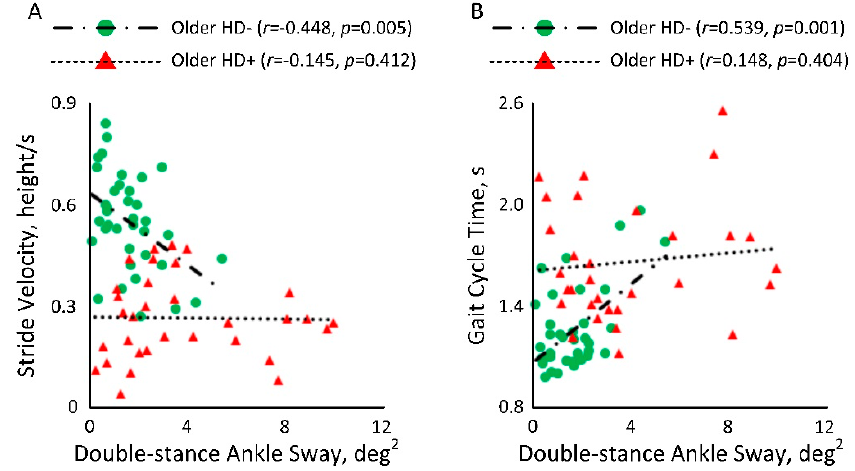
Figure 4. Correlation between double-stance ankle sway and ( A ) normalized stride velocity and ( B ) gait cycle time among older adults with diabetes with and without HD.